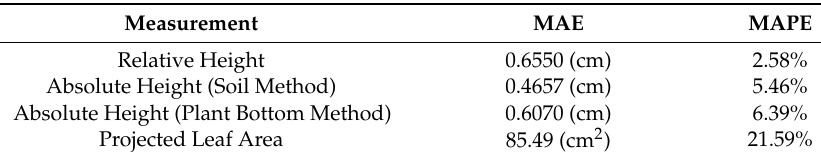
Table 4. Error of the measurements with linear relationships.